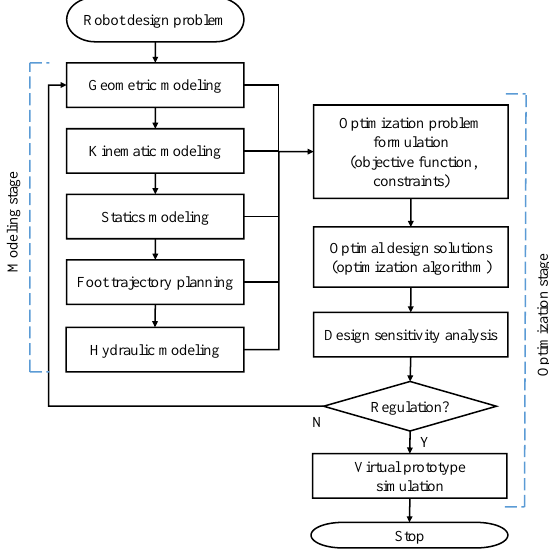
Figure 2. Robot modeling and design process.